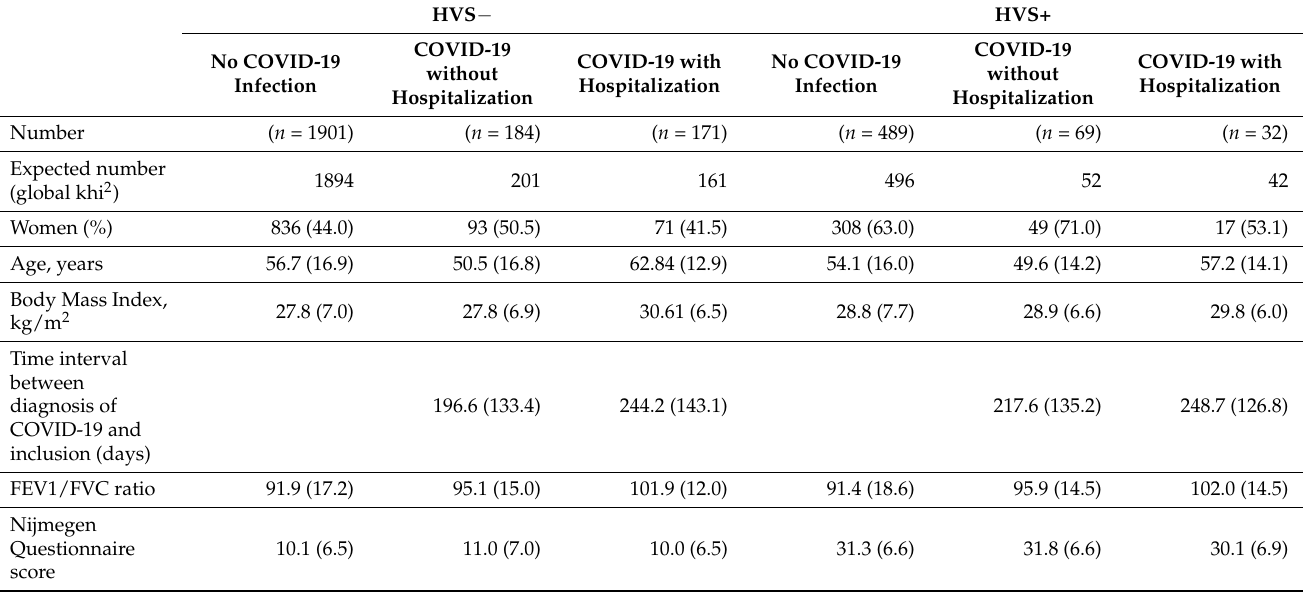
Table 3. Baseline demographic and clinical characteristics of included patients, according to HVS diagnosis, COVID-19 diagnosis, and strategy care ( n =